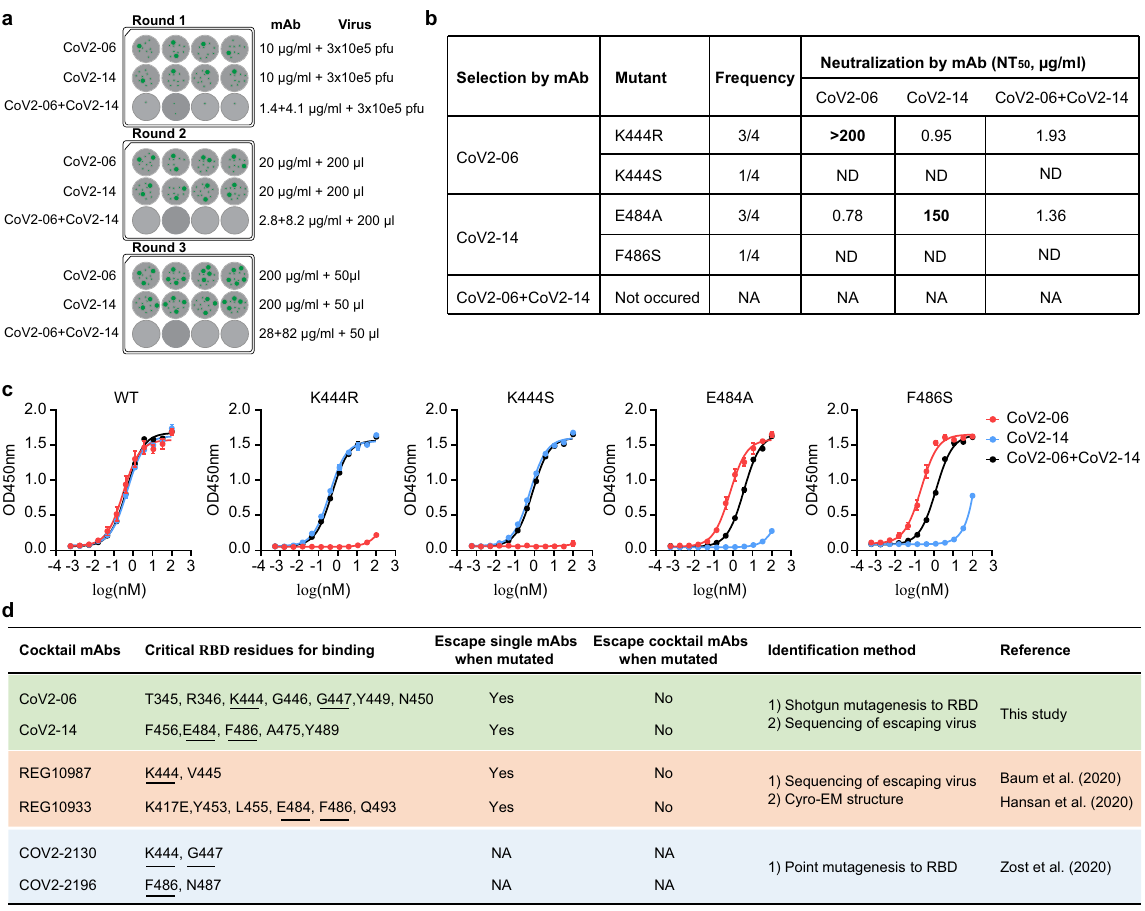
binding sites (K444R + E484A, K444R + F486S, K444S + E484A, and K444S + F486S) (Supplementary Fig. 5a). These single-site or double-site RBD mutants were analyzed for their af fi nity to ACE2 (Fig. 6a and Supplementary Fig. 5b – j), protein expression (Fig. 6b), and folding stability (Fig. 6c). Single-site mutations of K444R, K444S, E484A, and F486S reduced the sCoV2RBD/ACE2 binding af fi nities to 56%, 61%, 79%, and 6% of the wild-type (WT), respectively. In comparison, double-site mutations of K444R + E484A, K444R + F486A, K444S + E484A, and K444S + F486S further reduced the sCoV2-RBD/ACE2 binding af fi nities to 23%, 9%, 19%, and 3% of the WT, respectively (Fig. 6a and Supplementary Fig. 5b – j). Similarly, while single-site mutations altered the RBD expression to 69 – 110.1% of the WT, double-site mutations reduced the expression to 25.5 – 84.2% of the WT (Fig. 6b). The size exclusion chromatography (SEC) analysis showed protein aggregates of 0.88 – 11.42% and 4.99 – 14.74% for RBD with single-site mutations and double-site mutations, as compared to only 0.21% of aggregates for WT RBD (Fig. 6c). These data indicate that double mutations at both the CoV2-06 and CoV2-14 epitope sites attenuated the receptor-binding af fi - nity and stability of the RBD more than that of the single-site